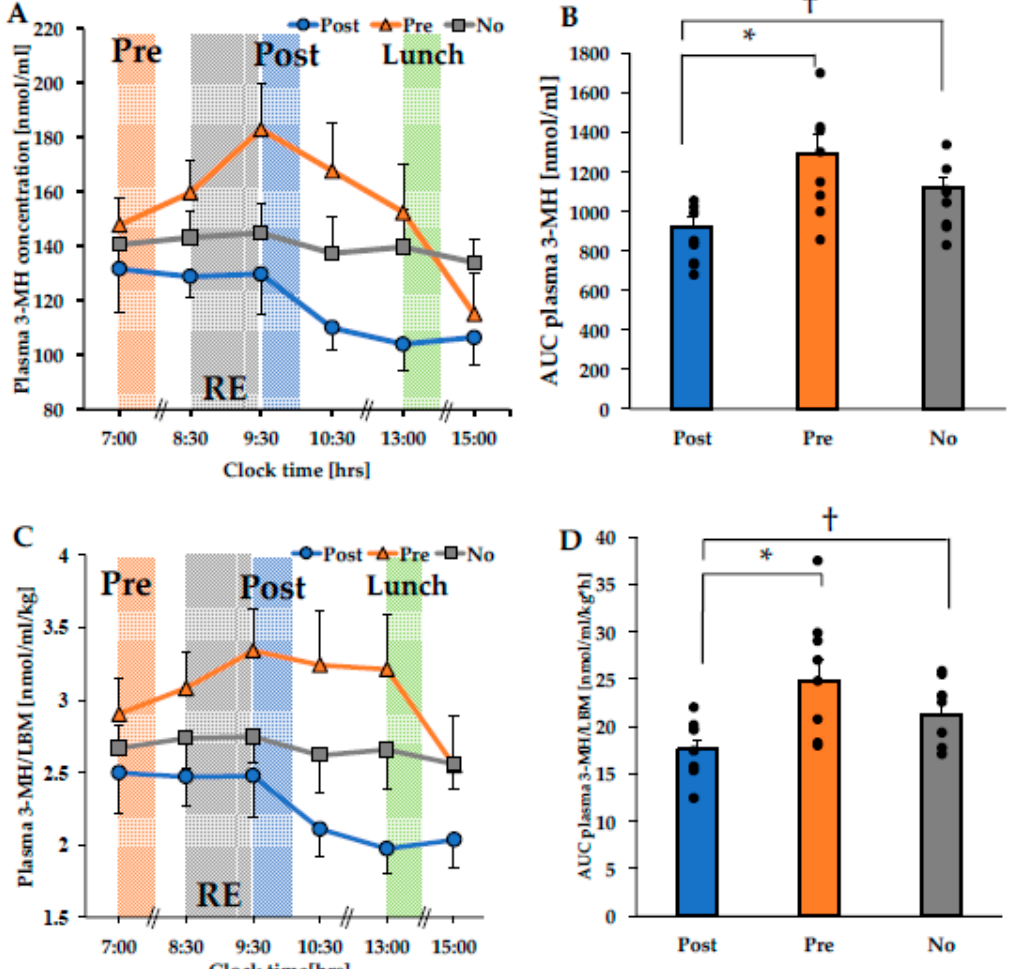
Figure 3. Time course change in plasma 3-MH concentration ( A ), the area under the curve of plasma 3-MH concentration (7:00–15:00) ( B ), time course change in plasma 3-MH / LBM levels ( C ), the area under the curve of plasma 3-MH / LBM levels (7:00–15:00) ( D ). * p = 0.016, † p = 0.007 ( B ), * p = 0.020, † p = 0.007 ( D ). RE: resistance exercise; Post: meal intake after RE; Pre: meal intake before RE; No: RE without meal intake; 3-MH: 3-methylhistidine; LBM: lean body mass.